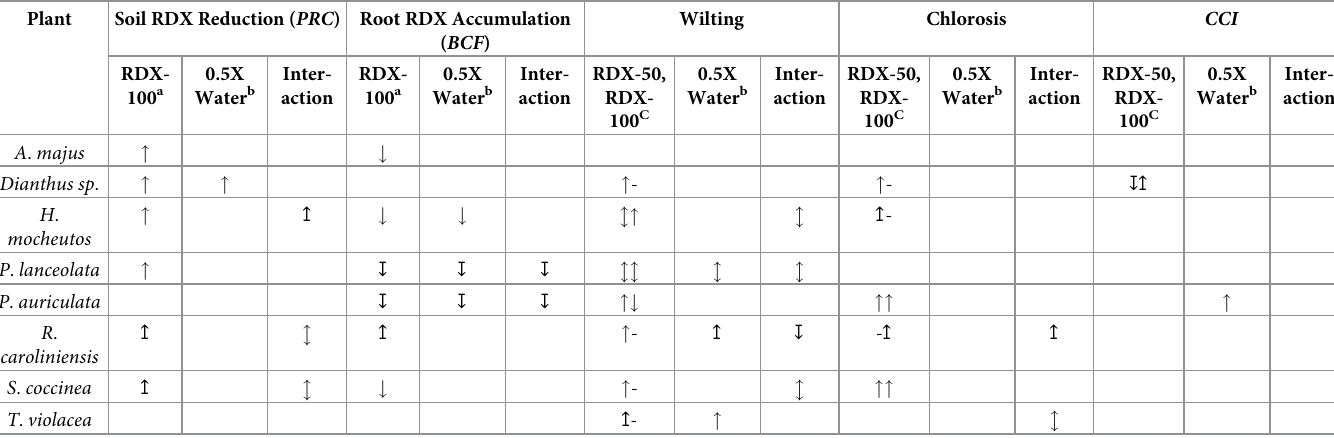
Table 4. Summary of patterns in RDX fate and plant health in greenhouse trial. Plant Soil RDX Reduction ( PRC ) Root RDX Accumulation ( BCF